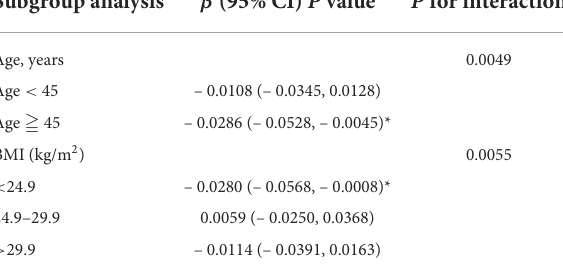
TABLE 4 Subgroup analysis of serum TC with lumbar spine bone mineral density, stratified by age and body mass